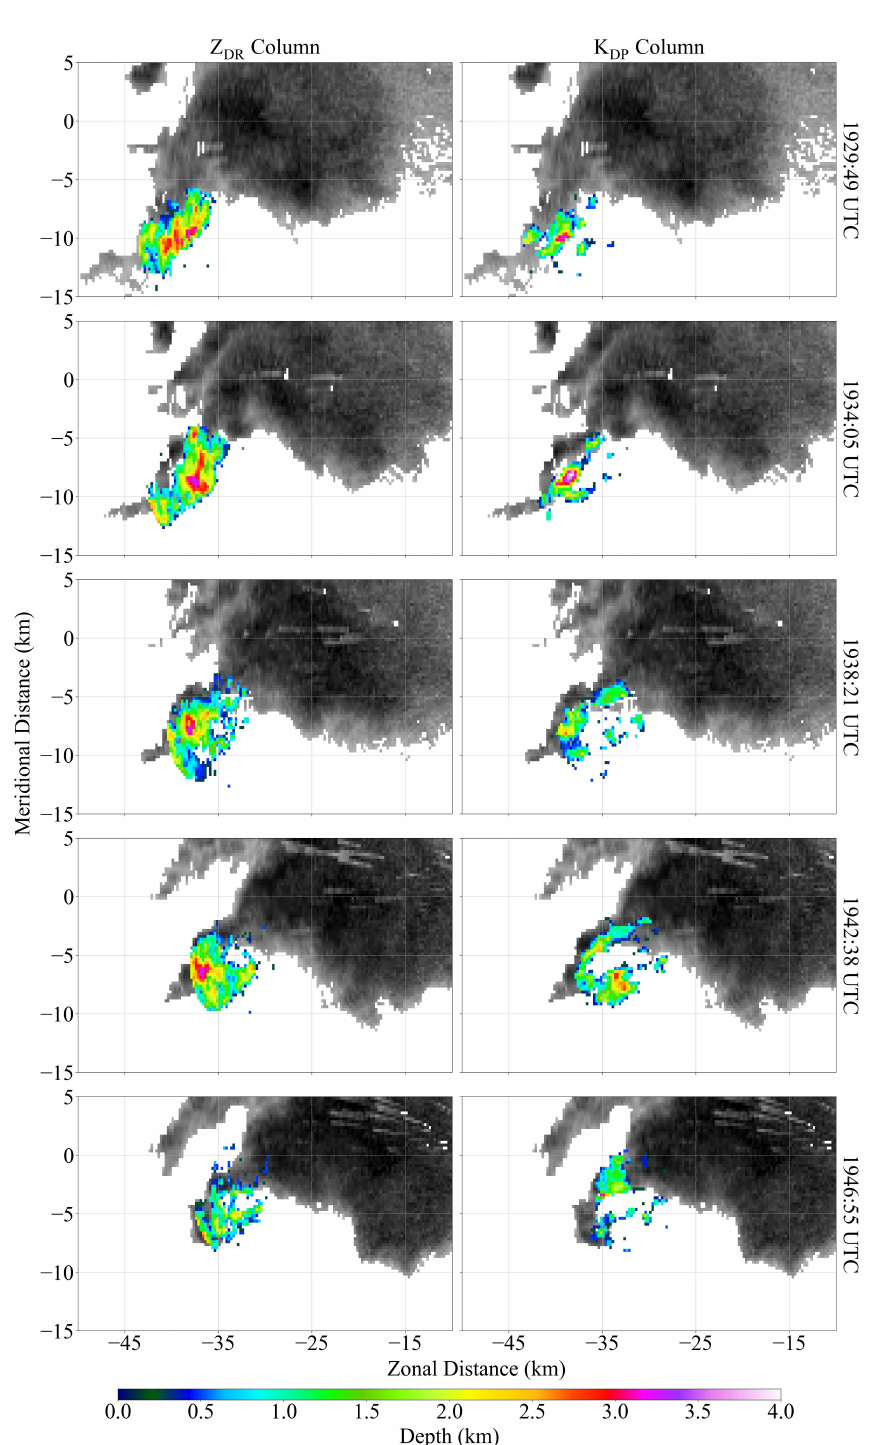
Figure 16. Plot of the depth field for Z DR and K DP columns from KTLX for five consecutive radar scans from 1929:49 to 1946:55 UTC (first period). The background grayscale shading is as in Figure